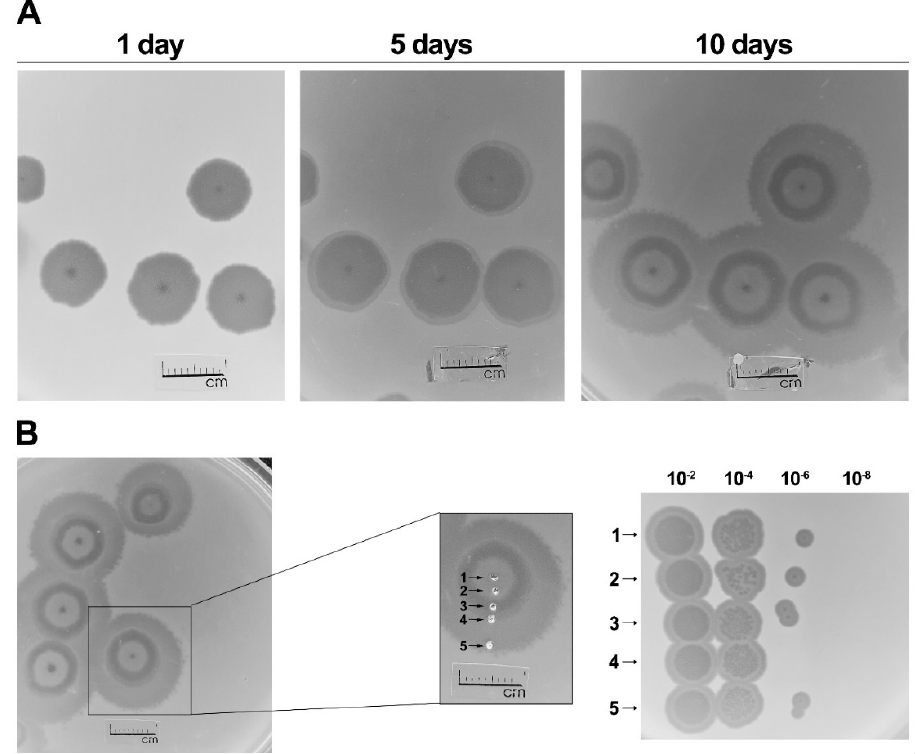
Figure 2. Morphology of plaques formed by vB_PagS_AAS23 on a lawn of Pantoea agglomerans strain AUR, and comparison of AAS23 count in the different plaque zones. ( A ) Plates were incubated at 22 ◦ C, numbers above indicate days of incubation. ( B ) Plates were incubated at 22 ◦ C for 10 days; the numbered rows indicate sampling sites in the different zones, and values at the top indicate dilution series.